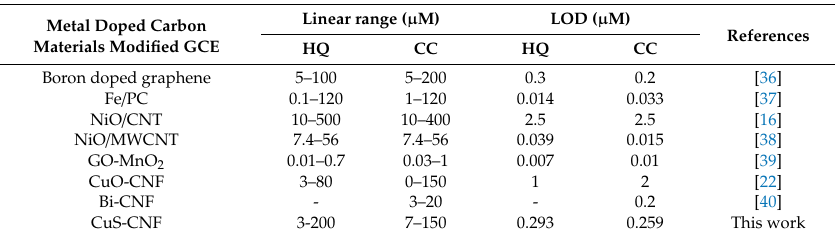
Table 1. Performance comparison of CuS-CNF / GCE with previously reported metal doped carbon materials modified GCE.